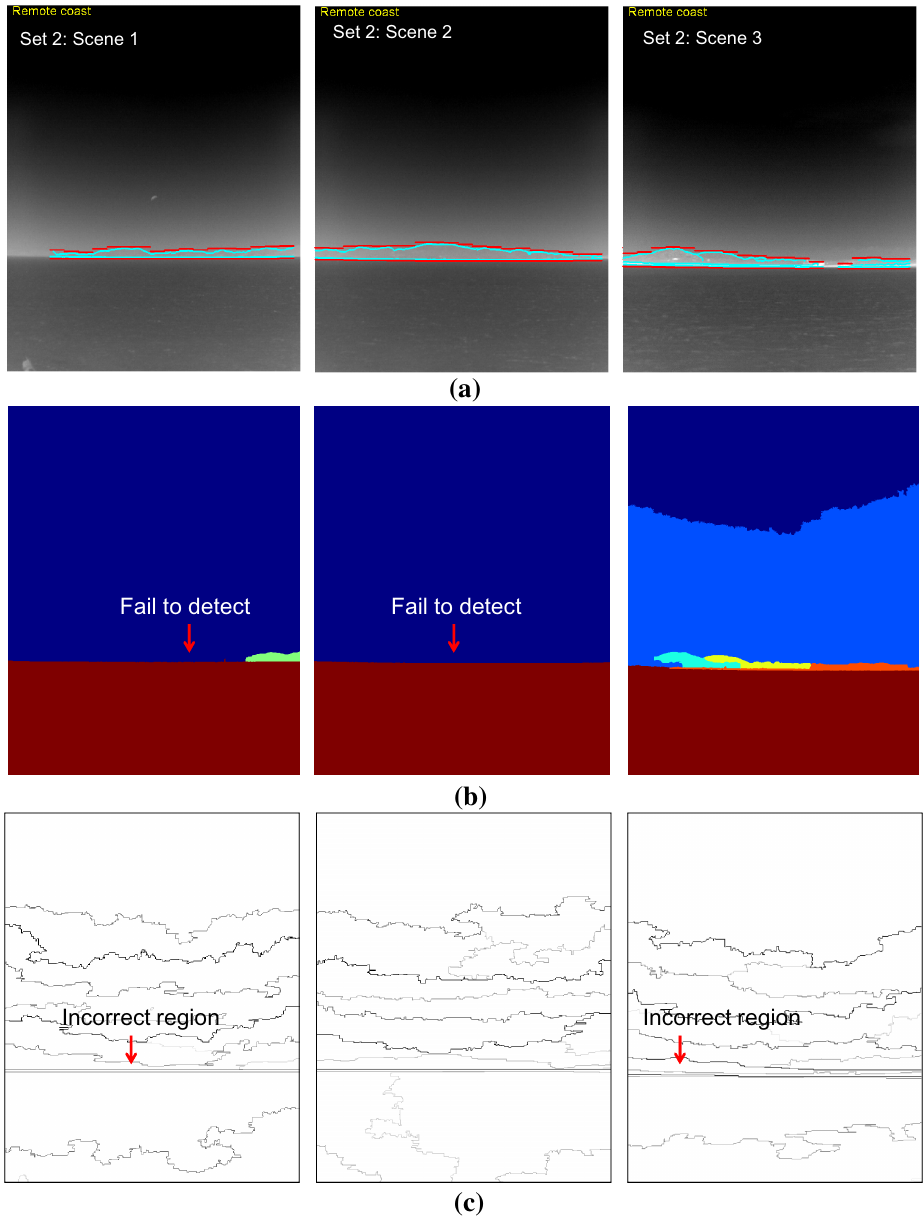
Figure 24. Comparison of the coastal region detection results for Test Set 2: ( a ) proposed coastal region detection; ( b ) mean-shift segmentation [28]: it failed for these test scenes; ( c ) statistical region merging method